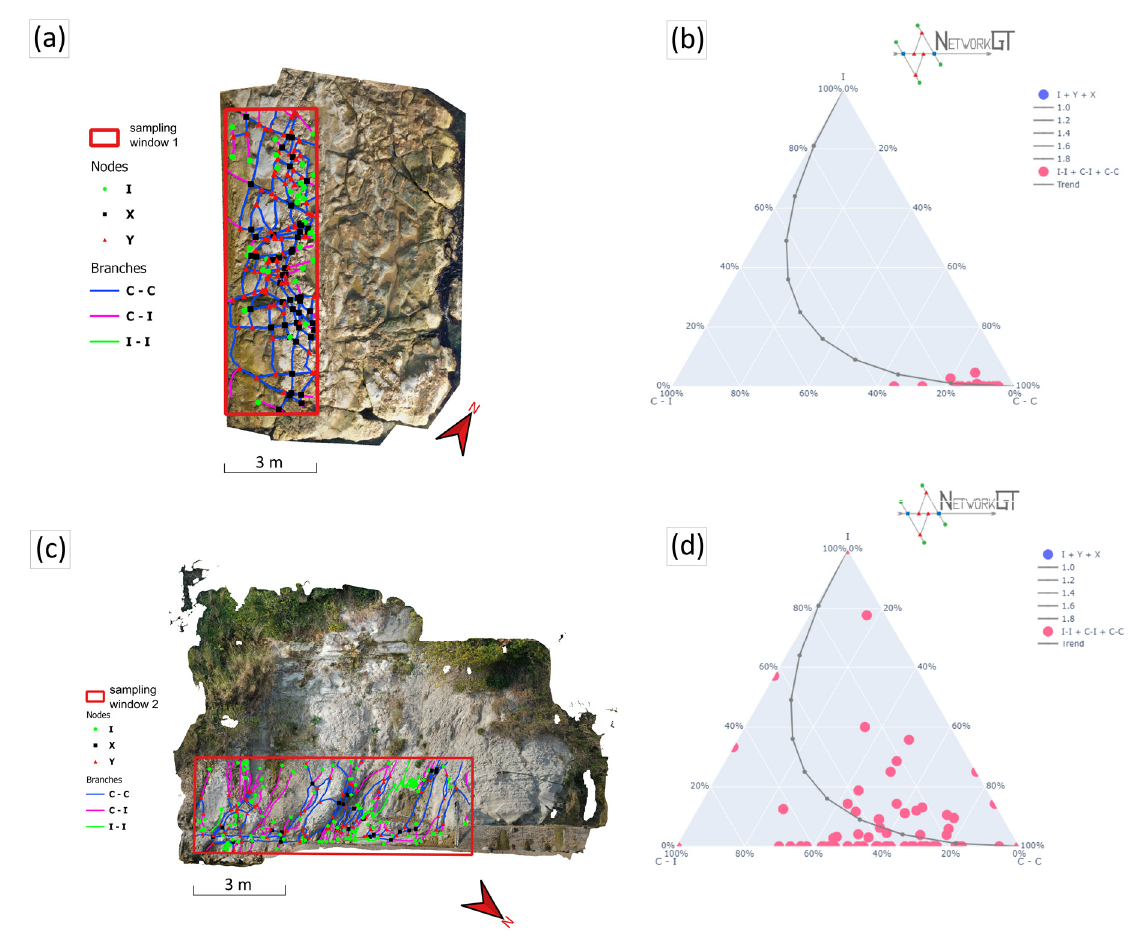
Figure 6. Topological analysis results for ( a ) sampling window 1 and ( c ) sampling window 2. The nodes of the fracture network are classified as isolated (I) nodes or connecting (Y or X) nodes. I-I = isolated-isolated, C-C = connected-connected. C-I = connected-isolated. Ternary plots are reported for sampling window 1 ( b ) and for sampling window 2 ( d ).